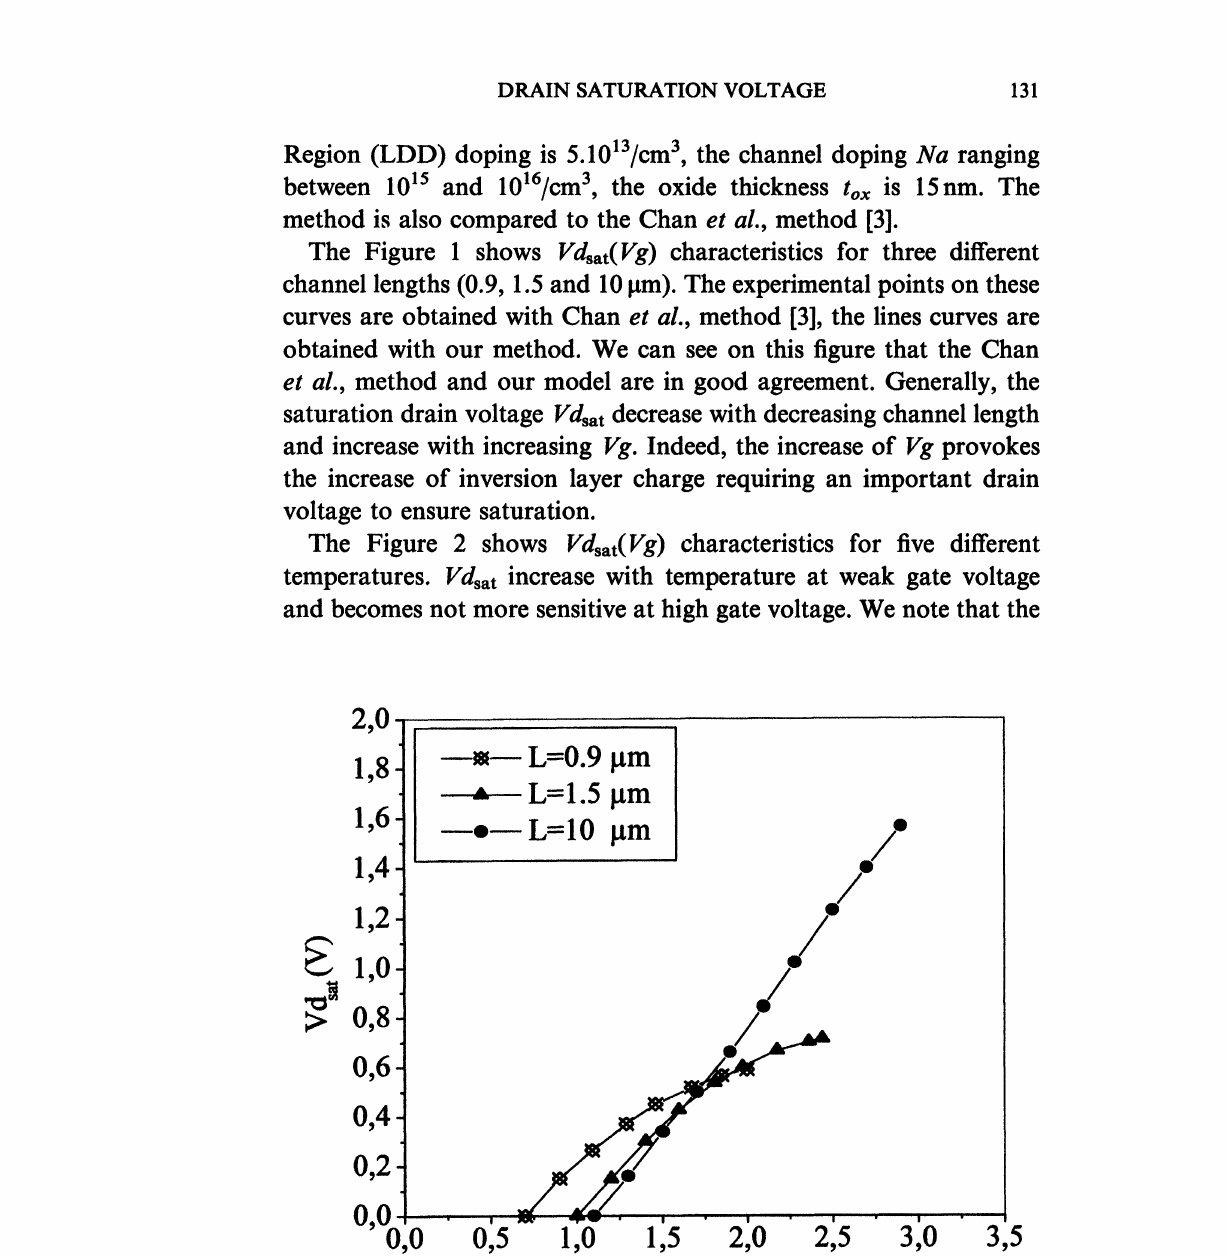
FIGURE Vdsat versus Vg characteristics for three different Channel lengths. (L 0.9, 1.5 and